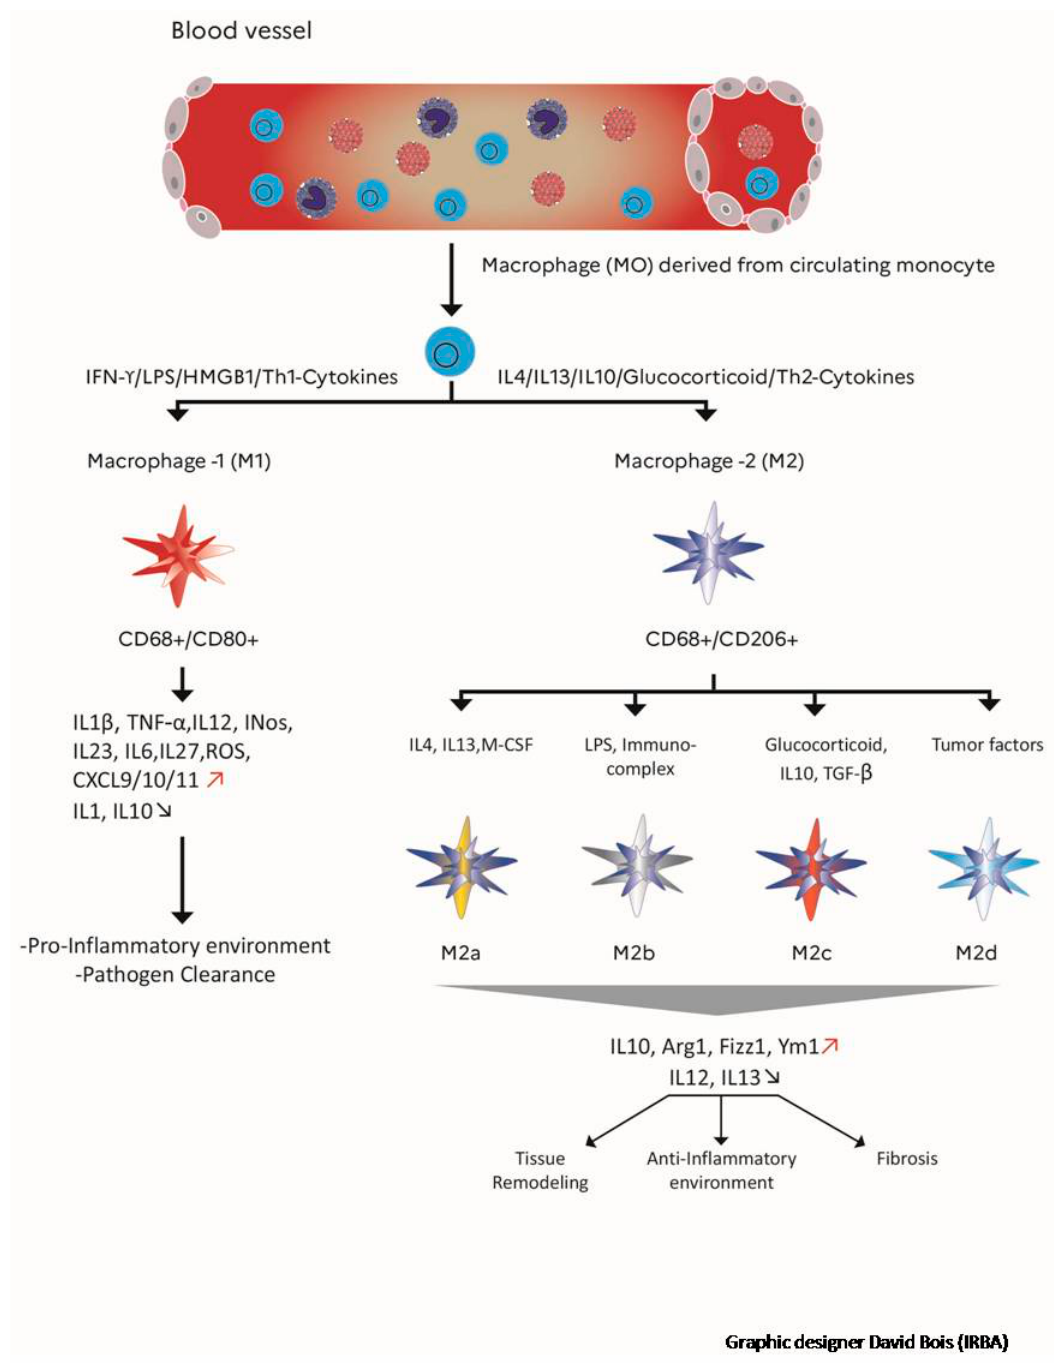
Figure 2. Role of macrophage polarization in inflammation, phenotype markers and signaling molecules involved in M1/M2, M2a, M2b, M2c, M2d. Importance of M1/M2 balance in tissue repair. The M1 CD68 +/CD80 + macrophages which are pro-inflammatory and the M2 CD68 +/CD206 + macrophages which are anti-inflammatory. Red arrows: elevation. Blue arrow: decrease